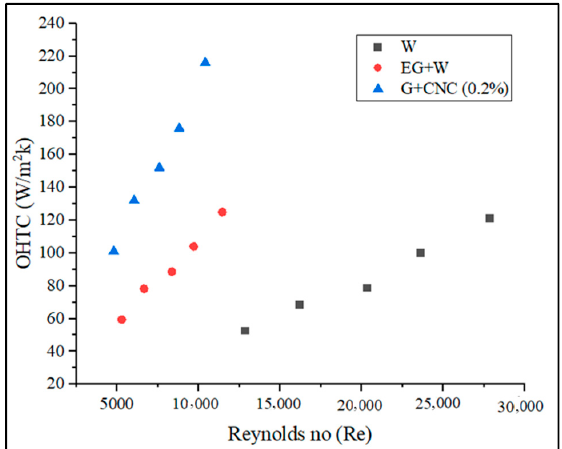
Figure 14. Overall heat transfer coefficient (OHTC) vs. Reynolds number (Re).